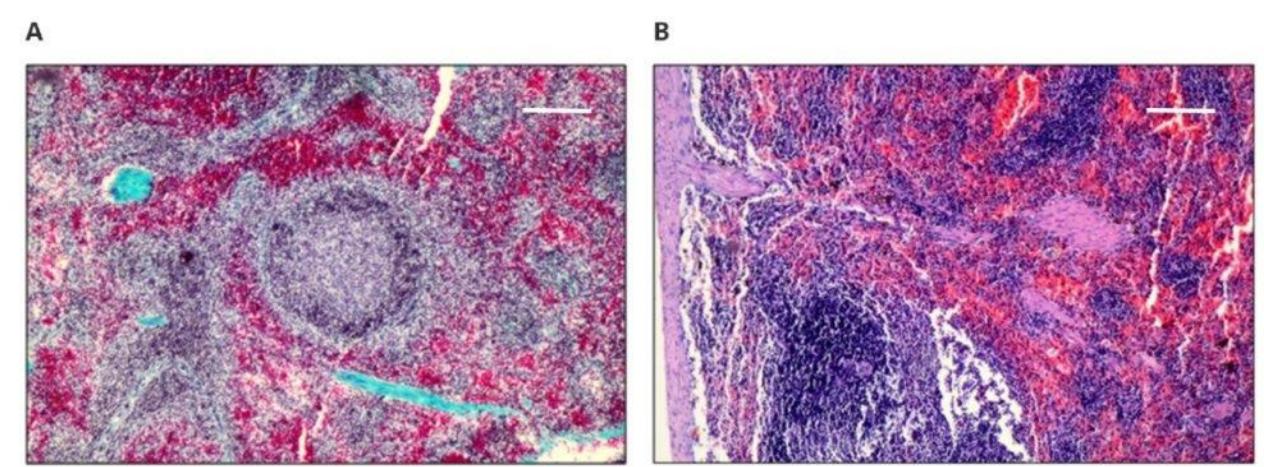
Figure 5. Microscopically assessed image of the spleen collected from animals with implants: ( A ) ( A ) 50 × magnification (scale bar 200 µ m), Masson’s staining, white pulp; ( B ) 50 × magnification (scale 50× magnification (scale bar 200 µm), Masson’s staining, white pulp; ( B ) 50× magnification (scale bar 200 µ m), Masson’s staining, red pulp. bar 200 µm), Masson’s staining, red pulp.